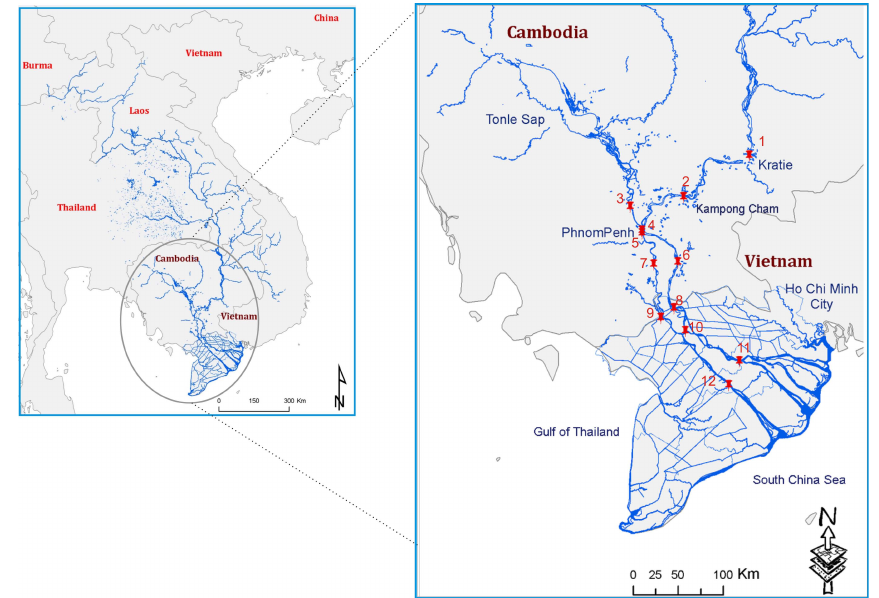
Fig. 1. The Mekong basin and delta and gauging stations in Cambodia and Vietnam used for the calibration (red points); station names are given in Table